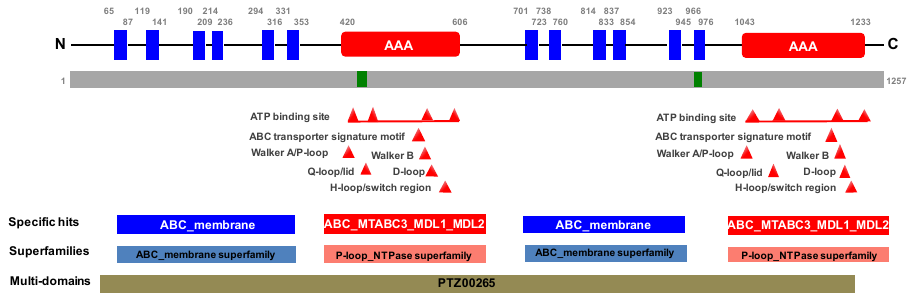
Figure 1. Schematic drawing of the primary and secondary structures of PxPgp1 . TMpred and the conserved domain database from NCBI were used to construct this map. Signature motifs of the ABC superfamily are color-coded, including transmembrane domains (blue), a nucleotide domain (red) and regions with low complexity (green). PTZ00265 in grey denotes a multidrug-resistance protein (mdr1).